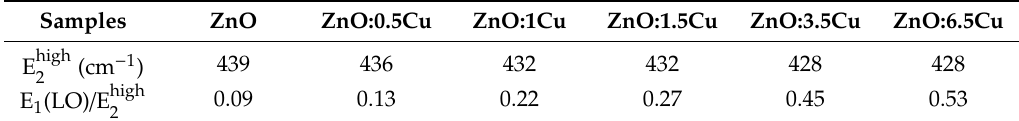
3.5, 6.5. and intensity ratios of E 1 (LO) to E high for the calcined pristine ZnO 2 2 and intensity ratios of E 1 (LO) to E high for the calcined pristine ZnO 2 2